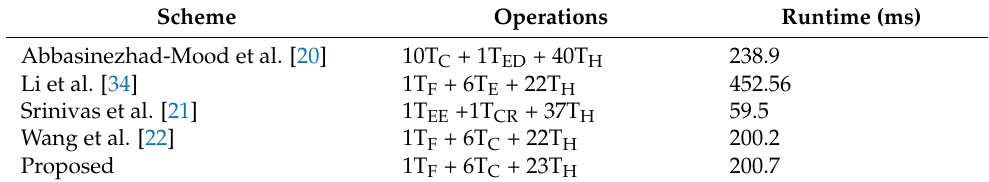
Table 3. Execution time comparison.